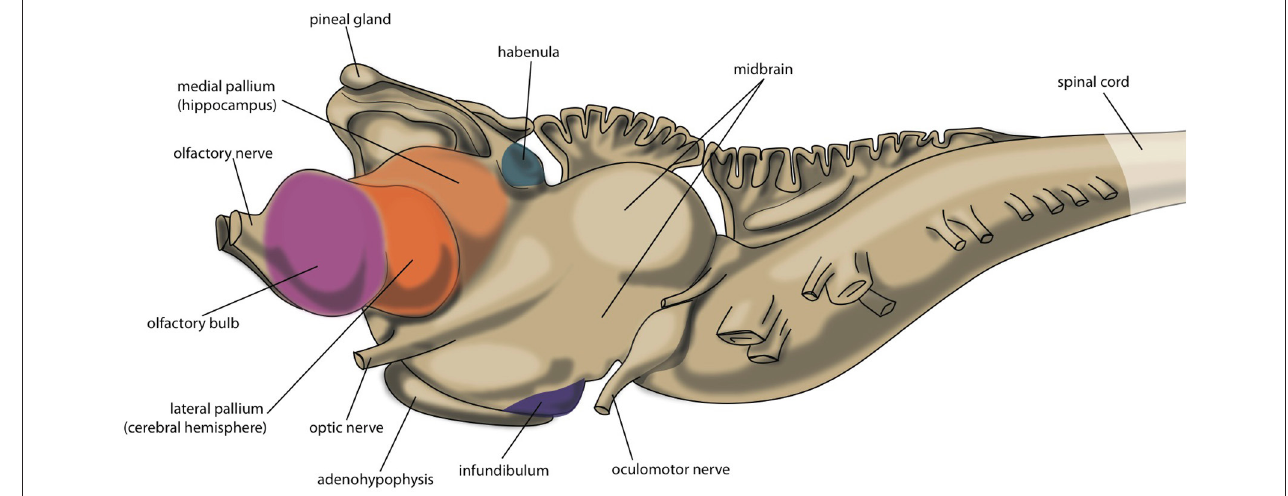
FIGURE 2 | Central nervous system of